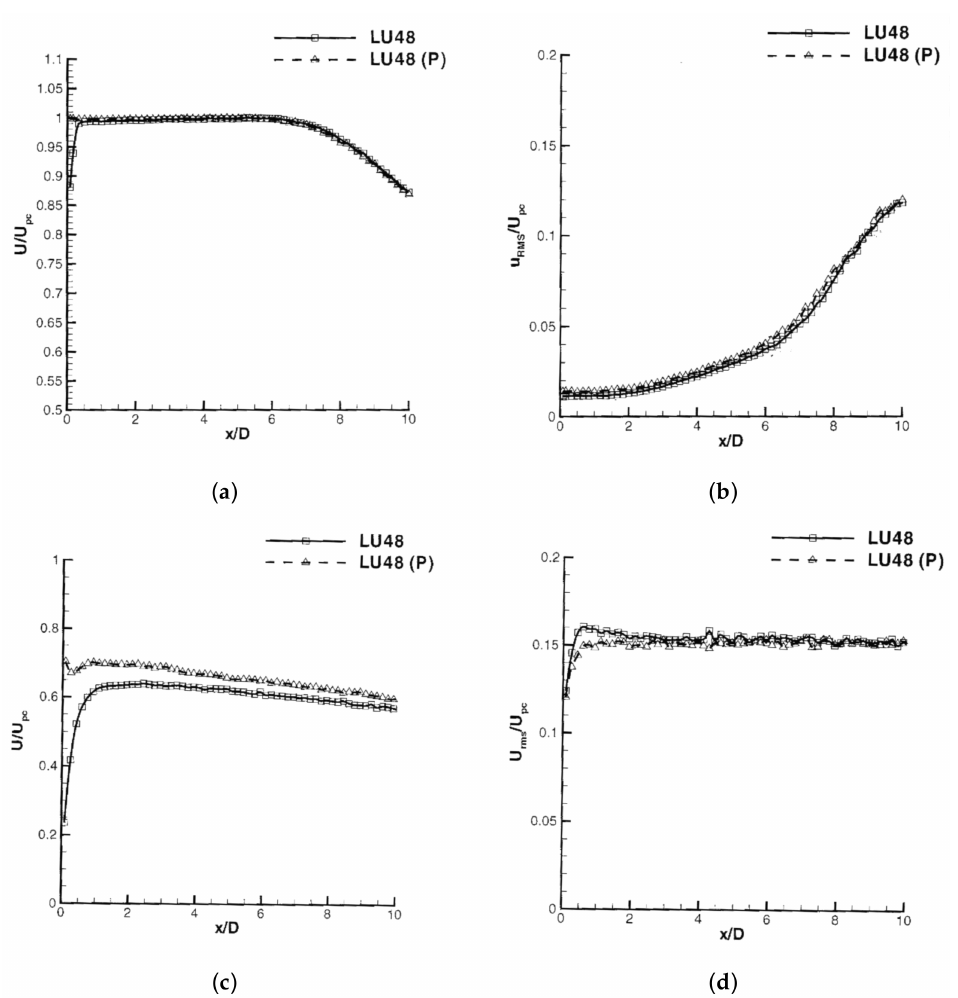
Figure 18. LU48/LU48P centreline and lipline profiles—NPR = 1.88. Top: centerline—( a ) axial velocity; ( b ) axial rms turbulence. Bottom: lipline—( c ) axial velocity; ( d ) axial rms